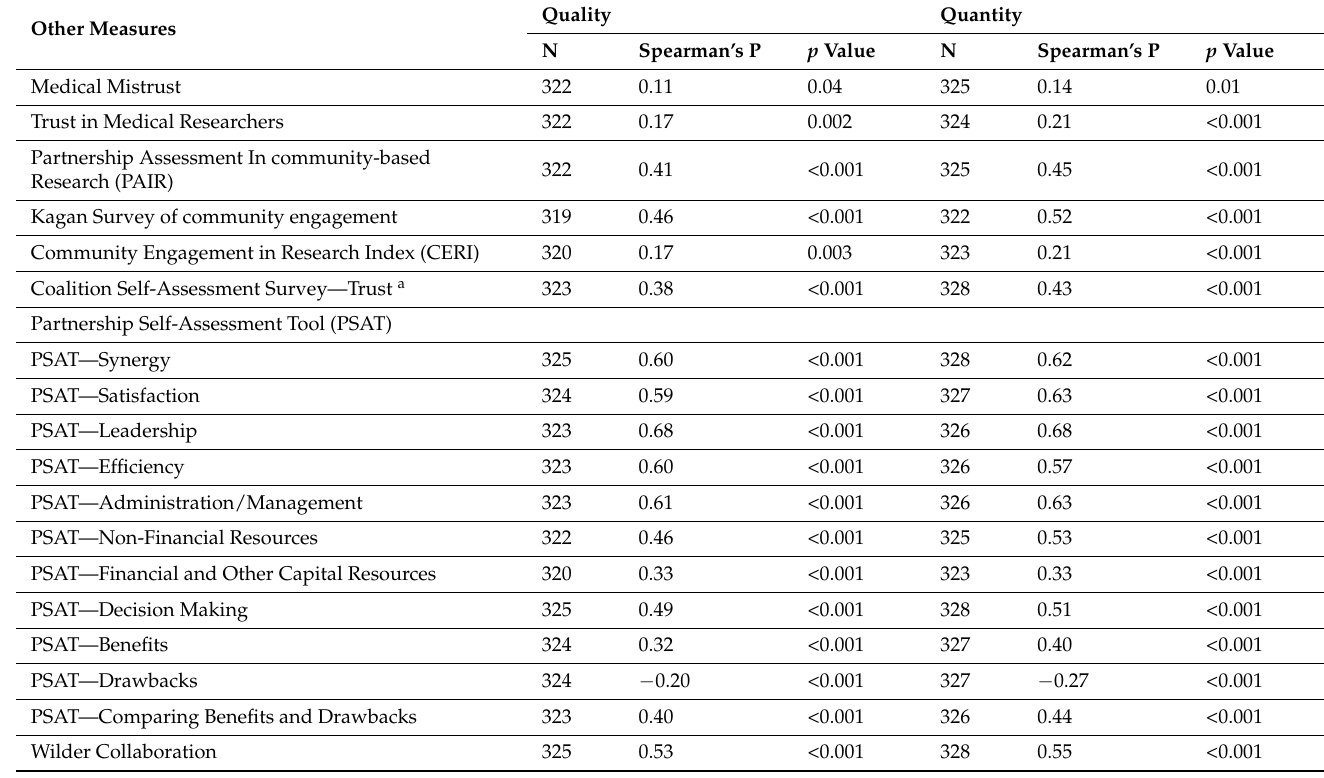
Table 4). For the quality scale, the condensed REST had low correlation with the following measures: PAIR (0.4), Kagan measure (0.5), the non-financial resources dimension of the PSAT (0.5), financial resources dimension of the PSAT (0.3), and the decision-making dimension of the PSAT (0.5; Table 4). The condensed REST had low correlation with the following measures for the quantity scale: PAIR (0.5), the Coalition Self-Assessment Survey—Trust subscale (0.4), benefits dimension of the PSAT (0.4), comparing benefits and drawbacks dimension of the PSAT (0.4), and the financial resources dimension of the PSAT (0.3). Table 4. Condensed REST Convergent Validity with Other